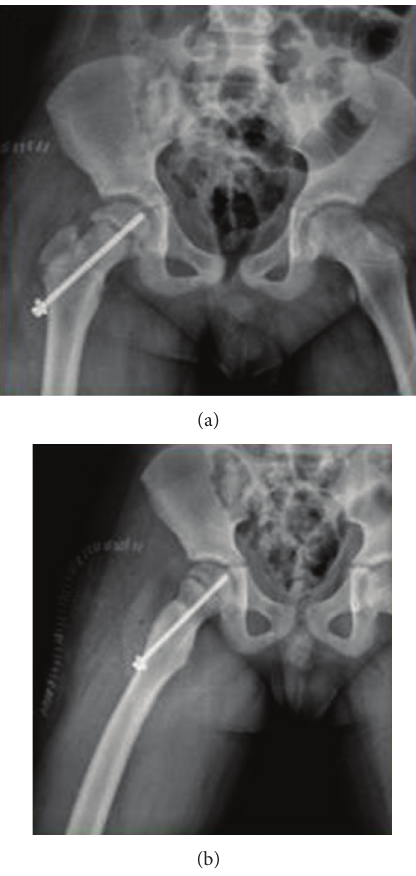
Figure 4: Postoperative (a) AP and (b) lateral views of related hip joint.